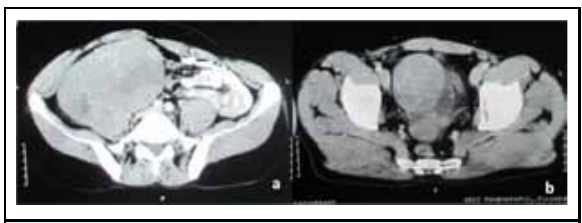
Figure 1. Ultrasonography of undescended testis pre- senting as an abdominal mass.